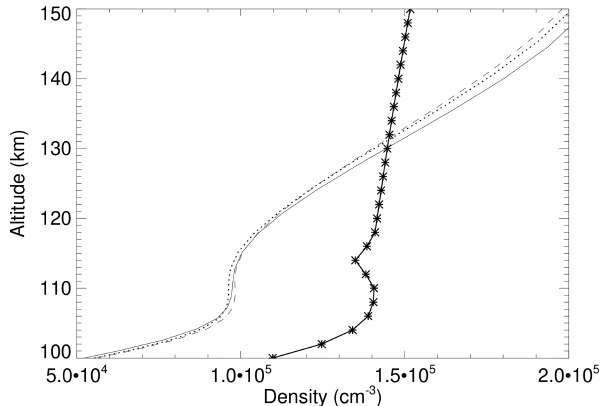
Figure 10. Altitude variation of electron density from three TIME- GCM simulations as compared with IRI, all for noon at the Equator. The thick solid line with stars is IRI, the thin solid line is the stan- dard nudged model, the short dotted line is the nudged with Kzz / 10 model and the dashed line is the nudged model with the reaction rate coefficient for N ( 2 D) + O